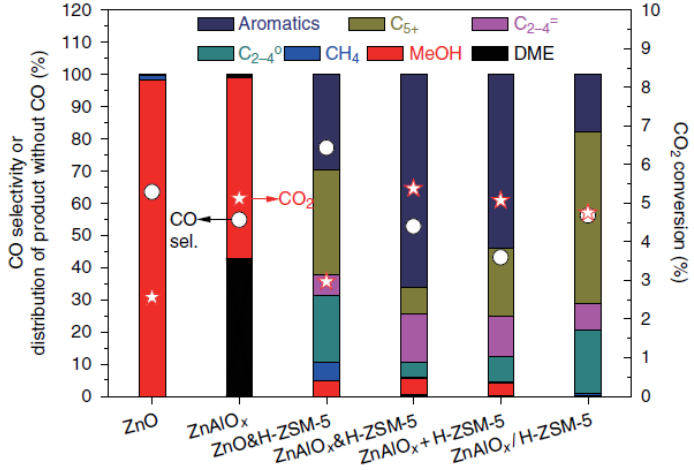
Figure 10. Catalytic performance over the ZnAlO x catalyst at T = 320 °C, P = 3 MPa and GHSV = 12,000 mL · g − 1 · h − 1 . Reproduced with permission from Ni et al. [32], published by Springer Nature, 2019.